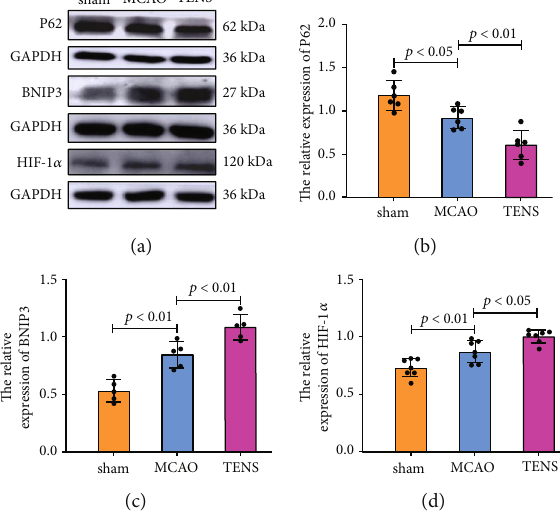
Figure 7: The e ff ect of TENS treatment on mitophagy-related proteins. (a) The expressions of P62, BNIP3, and HIF-1 α in the ipsilateral hippocampus were measured by western blot, in which GAPDH was used for the loading controls. (b, c, d) Statistical analysis of the expression di ff erence of P62, BNIP3, and HIF-1 α among three